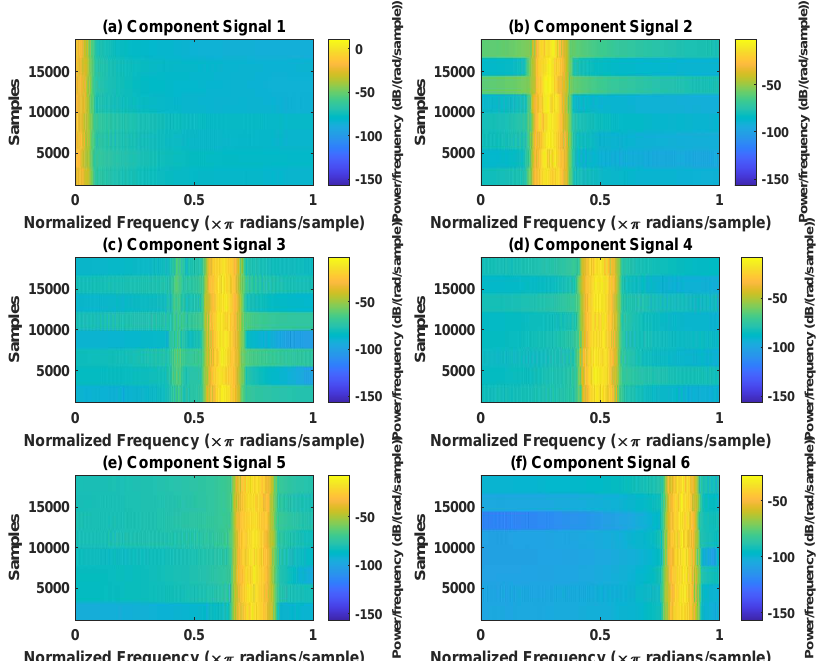
Figure 11. Decomposition results of ISVDP with m = 16 and J = 3: ( a – f ) time–frequency diagram of 1st to 6th subcomponents,